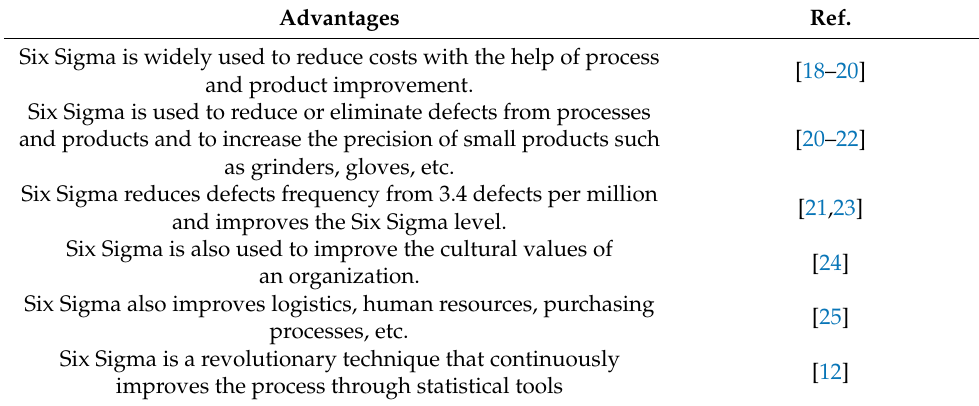
Table 2. Six sigma and its outcome. Advantages Ref.